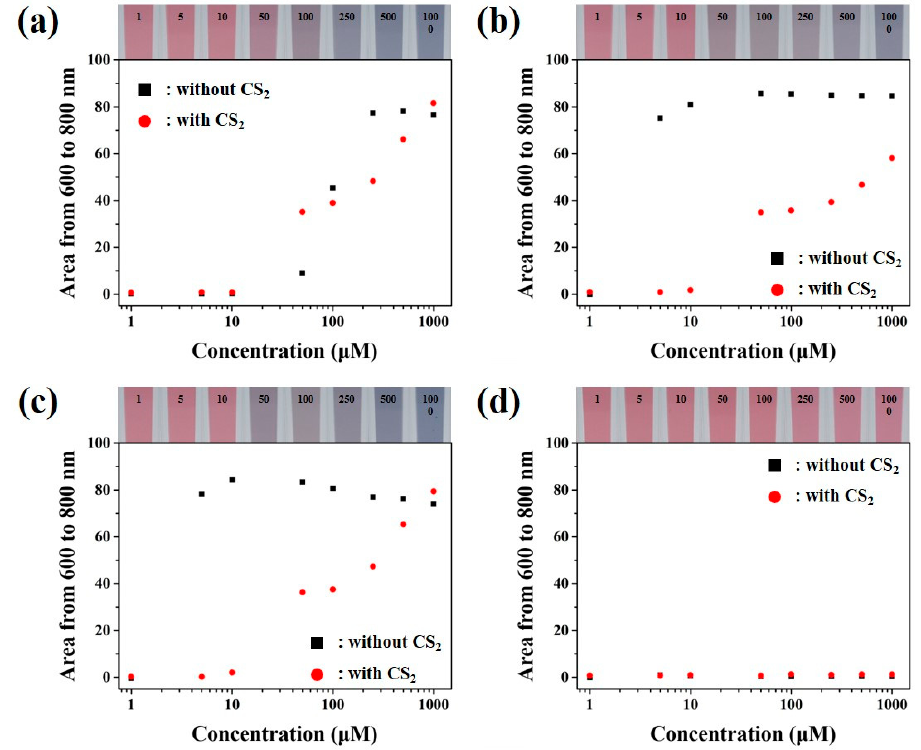
Figure 4. Absorption peaks of mixed BAs with various concentrations, ( a ) Cad, Put, Trm, ( b ) Cad, Put, Him, and ( c ) Cad, Him, Trm. ( d ) Adsorption peaks of multiple free amino acids (Arg, Lys, His and Glu) with various concentrations with visual analysis of colorimetric sensors in the presence of CS 2 for the detection of mixed BAs.